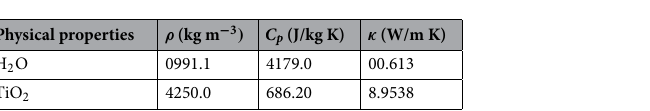
Table 1. Thermo-physical properties of water base fluid and nanoparticles 45 .